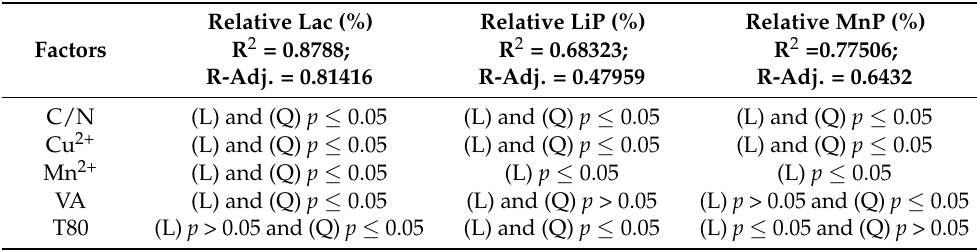
Table 2. Influence of linear (L) and quadratic (Q) factors for relative activities of Lac, LiP and MnP by p level from ANOVA.